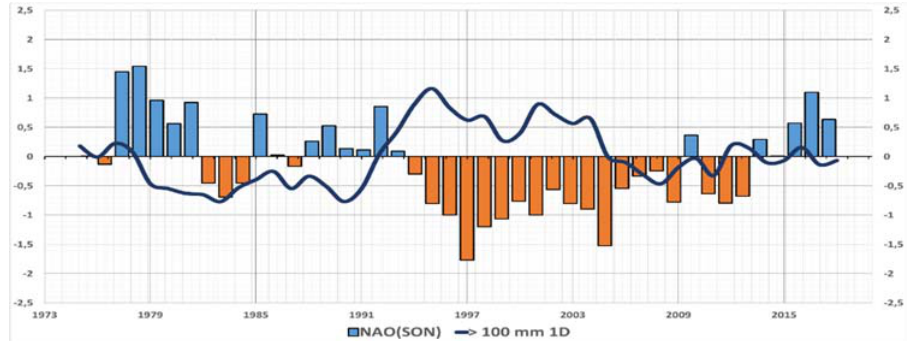
Figure 5. The evolution of centred small deviations of Mediterranean episodes (higher than 100 mm in 24 h) and of NAO indices for September, October and November (five ‐ year moving average) (1973–2020) ( RI = ( 𝑋𝑖 − 𝑋 )/ S ‐ where 𝑋𝑖 is yearly value, 𝑋 is the series average and S is standard deviation).